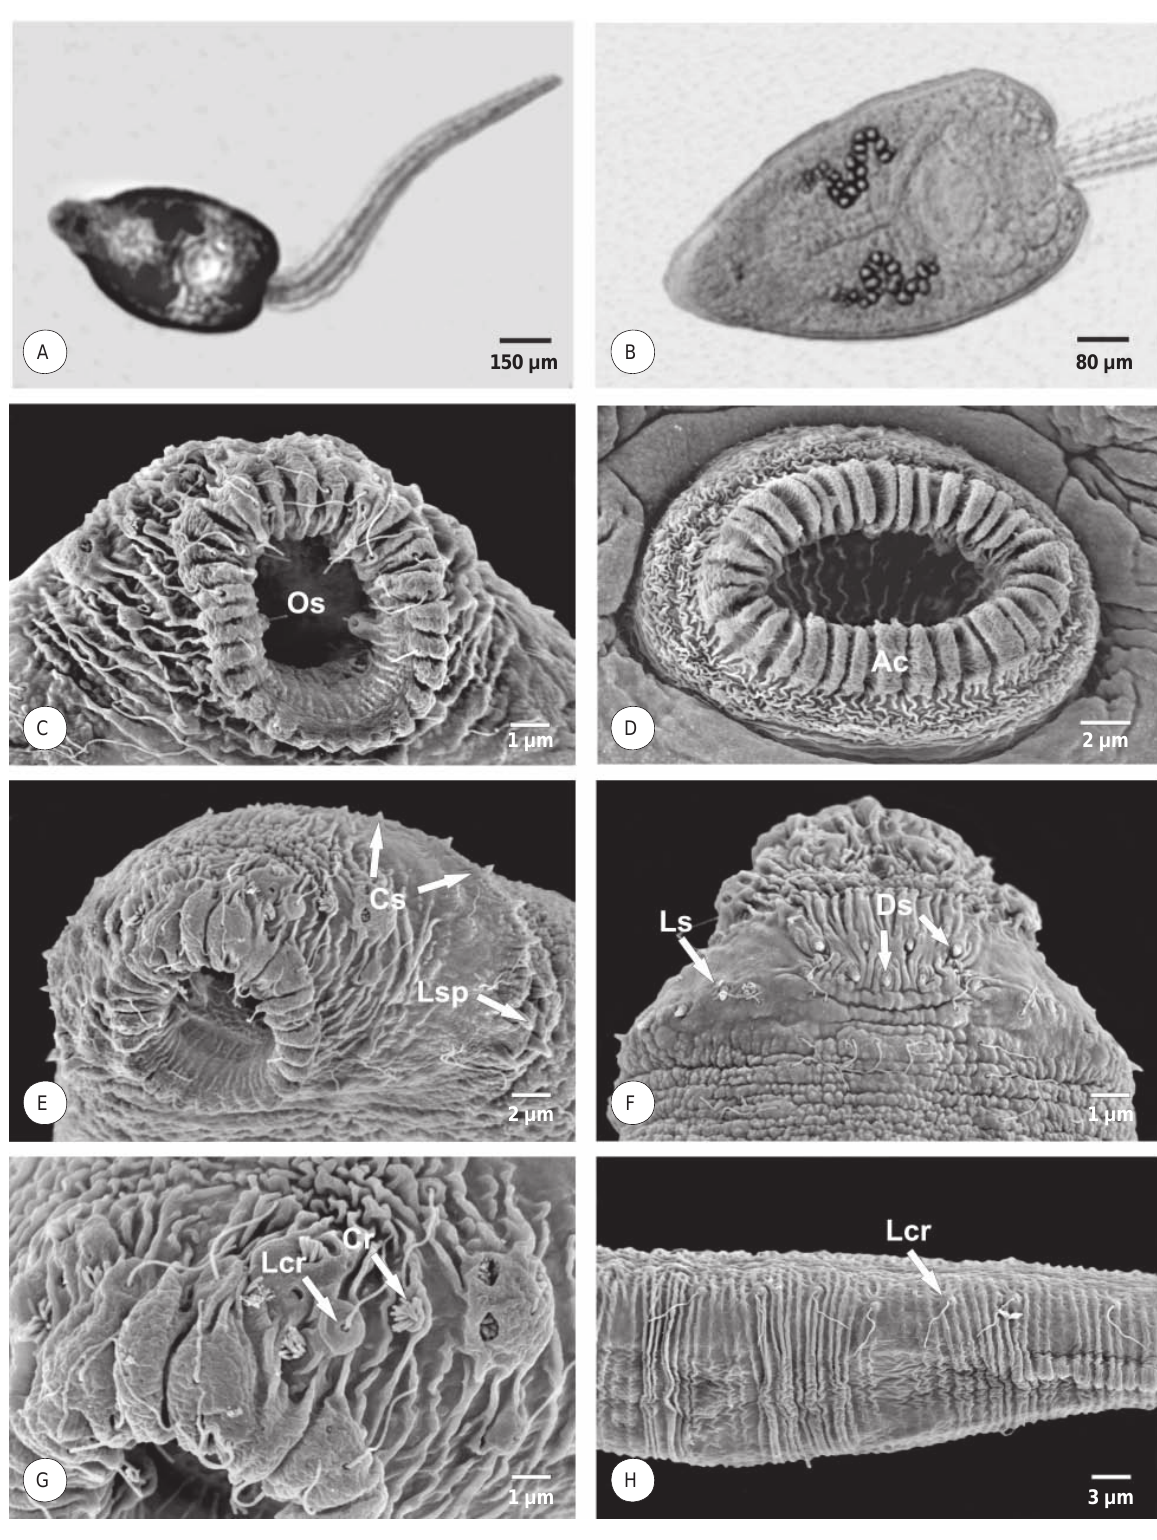
FIG. 3 Echinostomatid cercaria. Light micrographs of (A) whole mount; (B) head of cercaria; (C–H) scanning electron micrographs of cercaria: (C) oral sucker (Os) surrounded by long ciliated sensory receptors; (D) acetabulum (Ac); (E) sensory receptors along the oral sucker and collar showing corner (Cs) and lateral spines (Lsp); (F) tegumental features and collar spines, lateral spines (Ls) and dorsal spines (Ds); (G) long ciliated (Lcr) sensory and cluster receptors (Cr); (H) tail features with long ciliated receptors